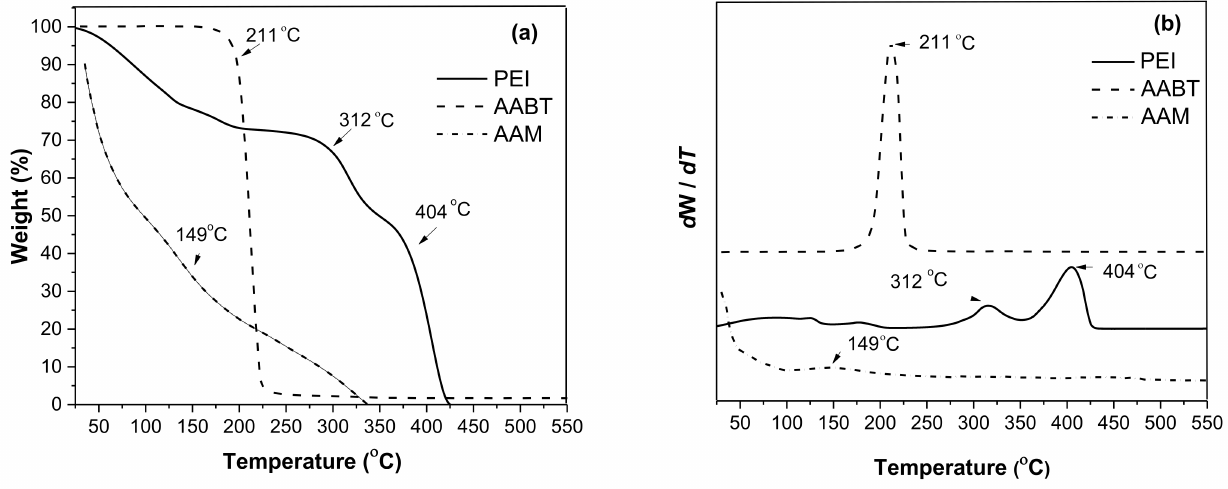
Figure 2. TGA thermograms of the stabilizers ( a ) and DTG curves of the stabilizers ( b ). The weight loss curves corresponding to the Cu NPs samples synthesized with the PEI, PEI/AABT, and PEI/AAM stabilizers are shown in Figure 3a. The organic coating content was estimated from the residual weight value at 600 ◦ C, obtaining a value of 4.6% for PEI, 8.7% for PEI/AABT, and 10.7% for PEI/AAM. All samples showed an